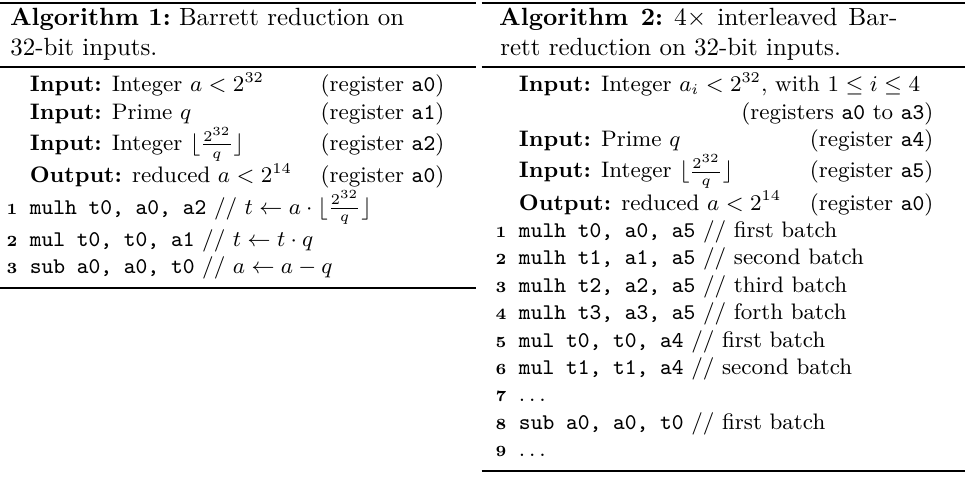
Algorithm 1: Barrett reduction on Algorithm 2: 4 × interleaved